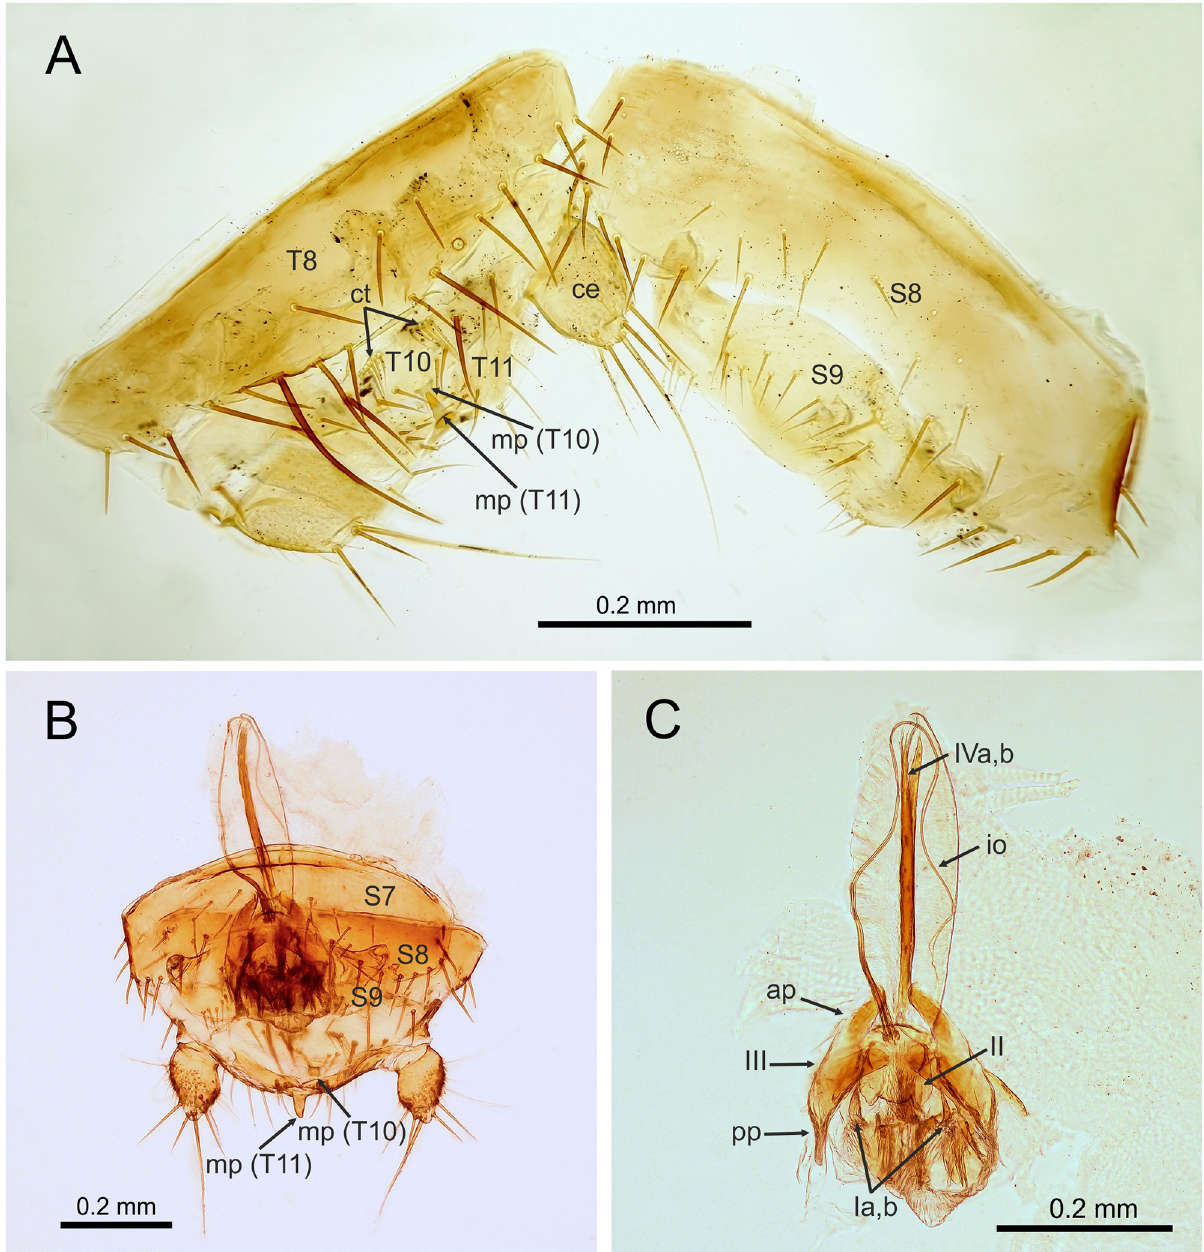
Fig 7. Latinozoros gimmeli sp. nov., apterous male paratypes. A: Posterior segments of male abdomen, dissected; B: Posterior segments of male abdomen, partly dissected, ventral view; C: Dissected male genital, ventral view. Abbreviations: ap–anterior process of ventral sclerite (III) of male genital; ce–cercus; ct–ctenidium; io–intromittent organ of male genital; mp–median up-curved projection; pp–posterior process of ventral sclerite (III) of male genital; S–abdominal sternite; T–abdominal tergite; I–dorsal sclerites of male genital; II–mesal sclerite of male genital; III–ventral sclerites of male genital; IV—rod-like paired sclerites of male genital. Scale bars = 0.2 mm.